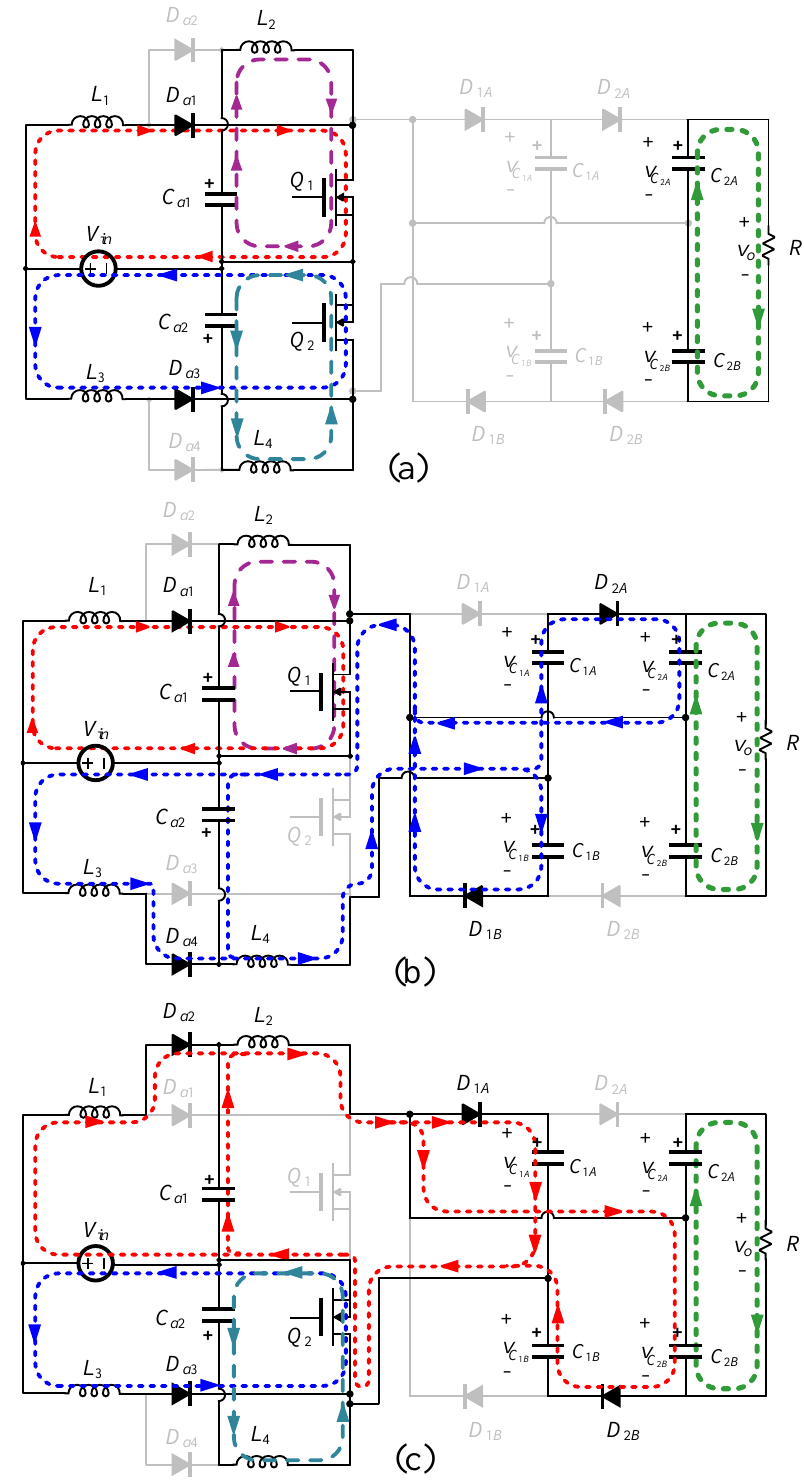
Figure 7. Equivalent circuits to ( a ) mode 1: both MOSFETs are ON, ( b ) mode 2: Q 1 is ON and Q 2 is OFF, and ( c ) mode 3: Q 1 is OFF and Q 2 is